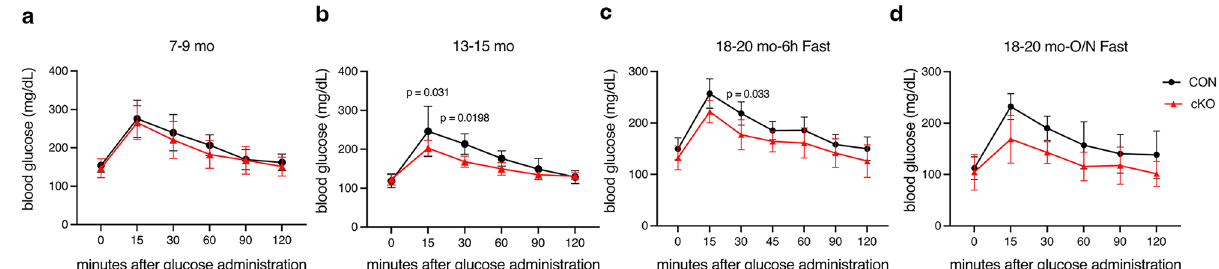
Figure 4. Older IKKα cKO mice show improved glucose tolerance. Glucose Tolerance Test (GTT) was performed after a 6 h fast at all ages and overnight (O/N) at 18–20 mo. CON = black, cKO = red, all male mice. Blood glucose measurements at ( a ) 7–9 mo (n = 7–9), ( b ) 13–15 mo (n = 5–6), ( c ) 18–20 mo (n = 4–7), and ( d ) 18–20 mo after O/N fast (n = 4–7). Data are represented as mean ± SD. Repeated measures 2-way ANOVA followed by Sidak multiple comparisons test, with p values indicated where significant.